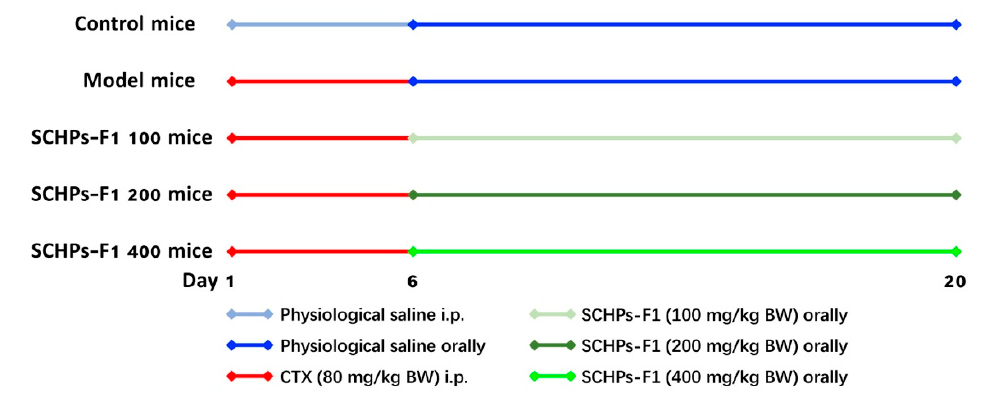
Figure 1. Outline of the experimental protocol regarding the treatment of the various